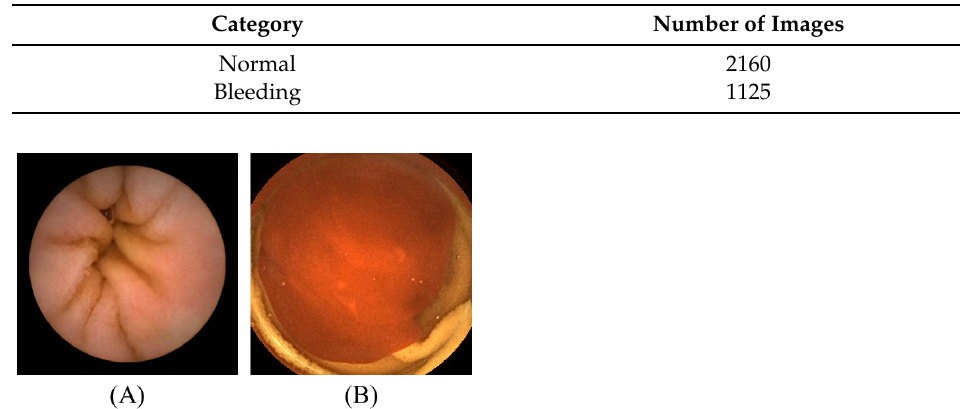
Figure A2. Examples of images in the RLE dataset [28]. ( A ) Normal; ( B )